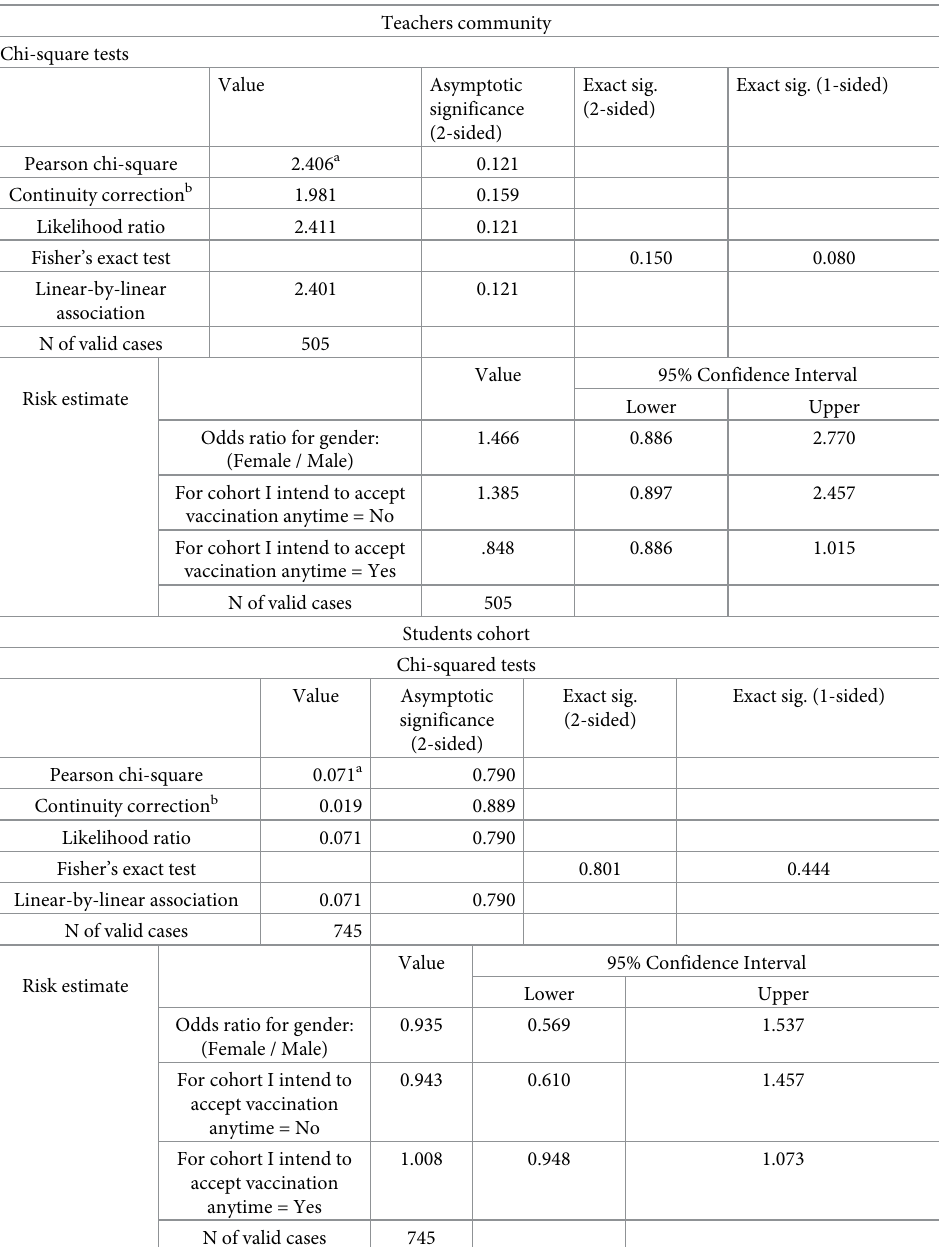
Table 6. Pearson’s Chi-squared test results in a comparative